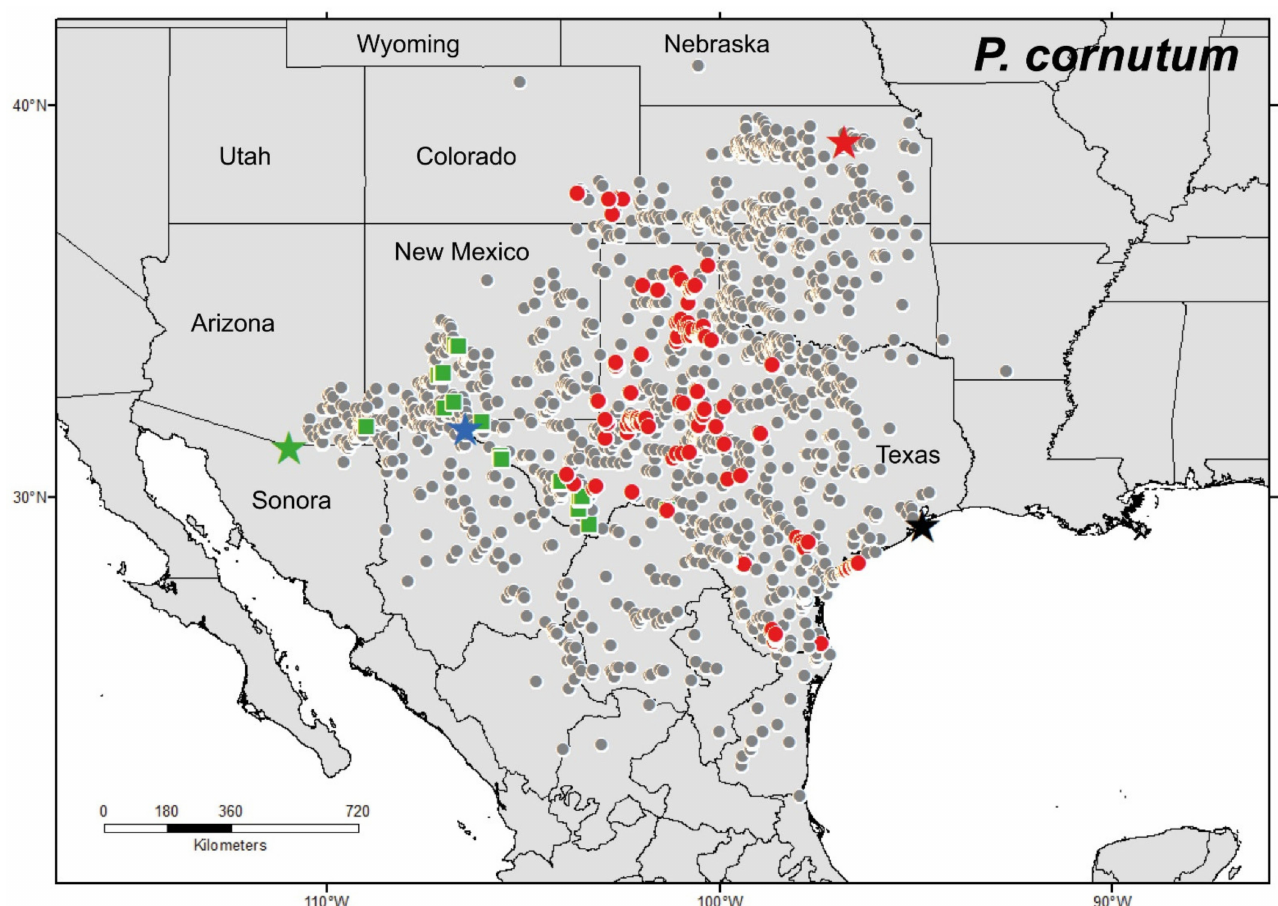
Figure 8. Map showing distributional records of Phrynosoma cornutum . Red circles = genetically confirmed records of P. c. cornutum ; green squares = genetically confirmed records of P. c. bufonium ; gray circles = records that have not been genetically confirmed; red star = type locality of P. cornutum ; green star = restricted type locality of P. bufonium ; black star = restricted type locality of P. brevicornis ; blue star = restricted type locality of P. planiceps